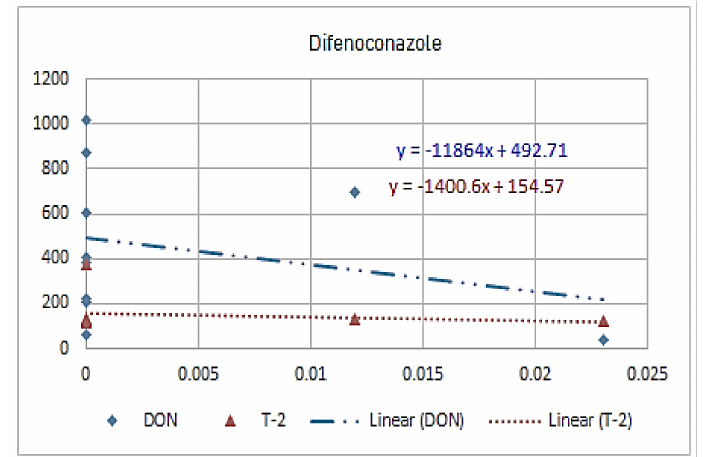
Figure 9. The relation between difenoconazole residue (ppb) and DON and T-2 toxin (ppb) in wheat